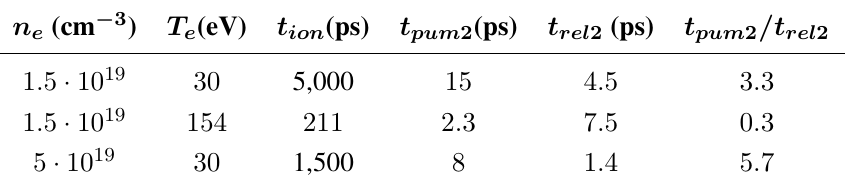
Table 2. Summary of the effects of the electron temperature and density on t ionization time to achieve Ne-like ions), t and t (total relaxation time from the upper level) at a wavelength λ = 46 . 9 nm in rel 2